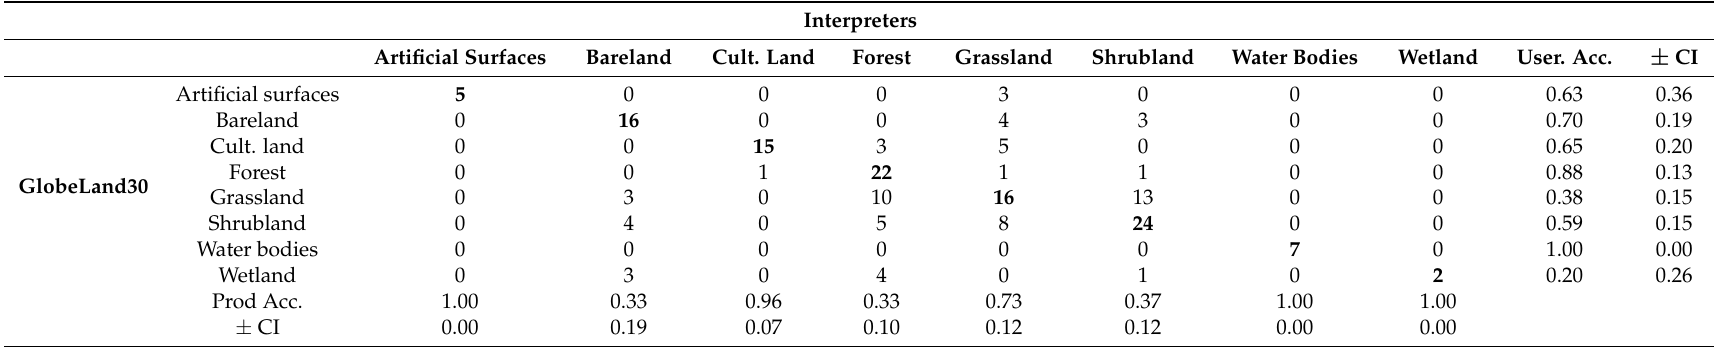
Table 5. Confusion matrix for Sample 1 ( n = 179) considering 3 × 3 pixel validations. User’s and producer’s accuracy with 95% confidence intervals shown. Overall